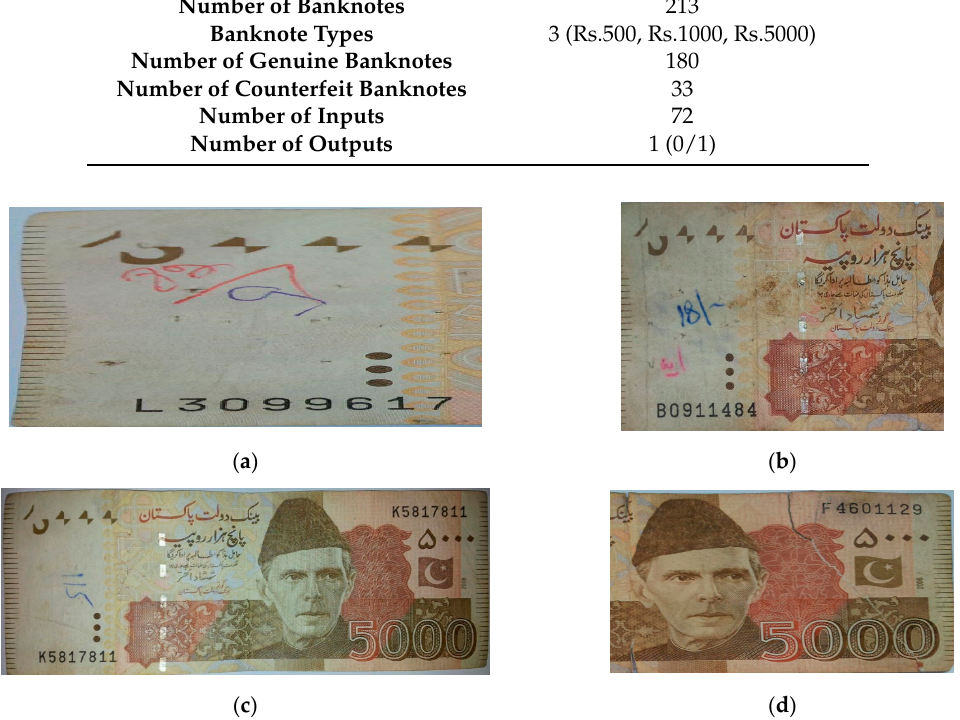
Figure 10. ( a ) Banknote with handwriting near the see through umber ( b ) Banknote with handwriting on left side ( c ) Washed banknote ( d ) Torn and then fixed banknote.